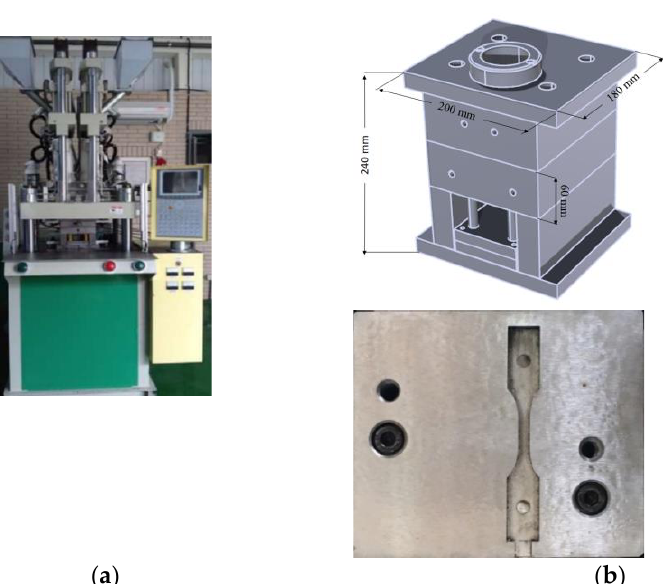
Figure 3. ( a ) Co-injection molding system and ( b ) the mold base and cavity